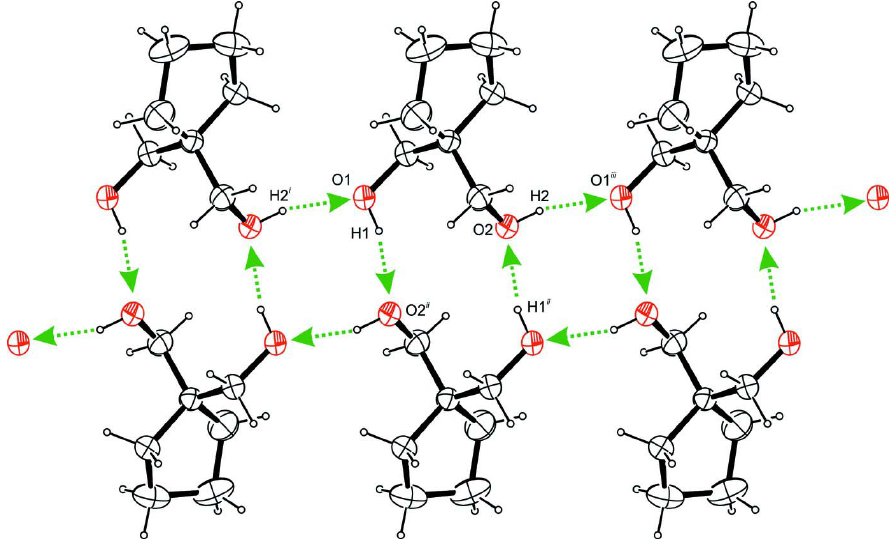
Figure 2 Hydrogen bonds in the crystal structure of the title compound, viewed along [0 1 0]. Symmetry operators: i x - 1, y , z ; ii - x + 1, - y + 1, - z ; iii x + 1, y , z